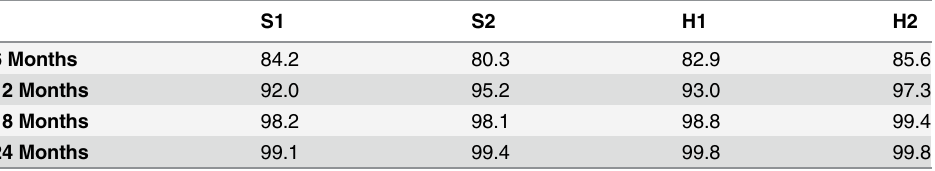
Table 3. Percentage reduction in micro fi larial density.